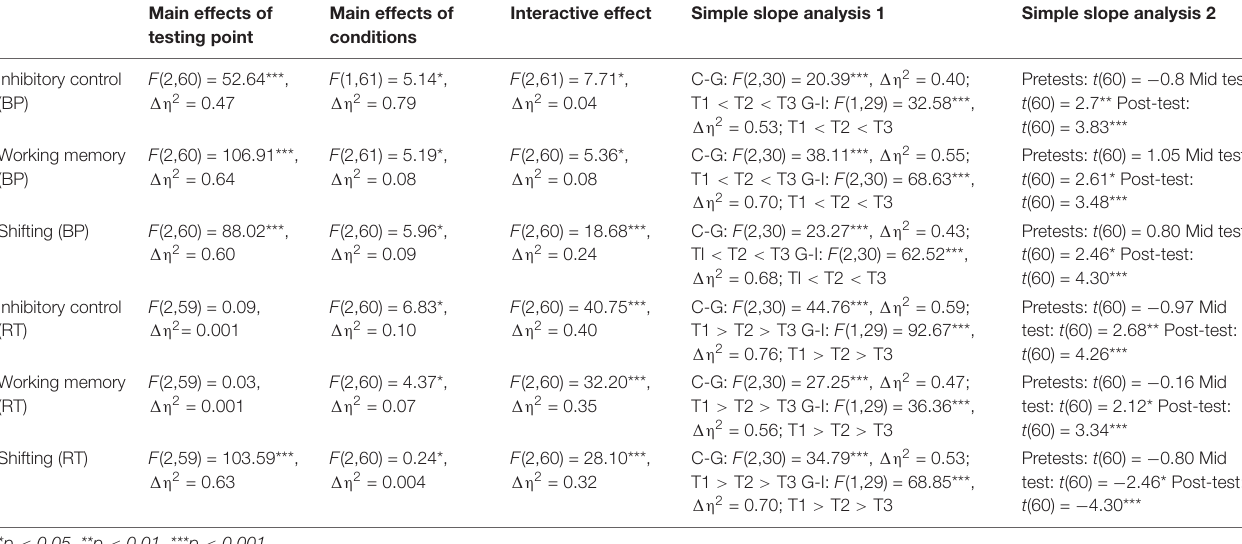
TABLE 2 | The effects of the group-play MVPA intervention program on EF and its dimensions.